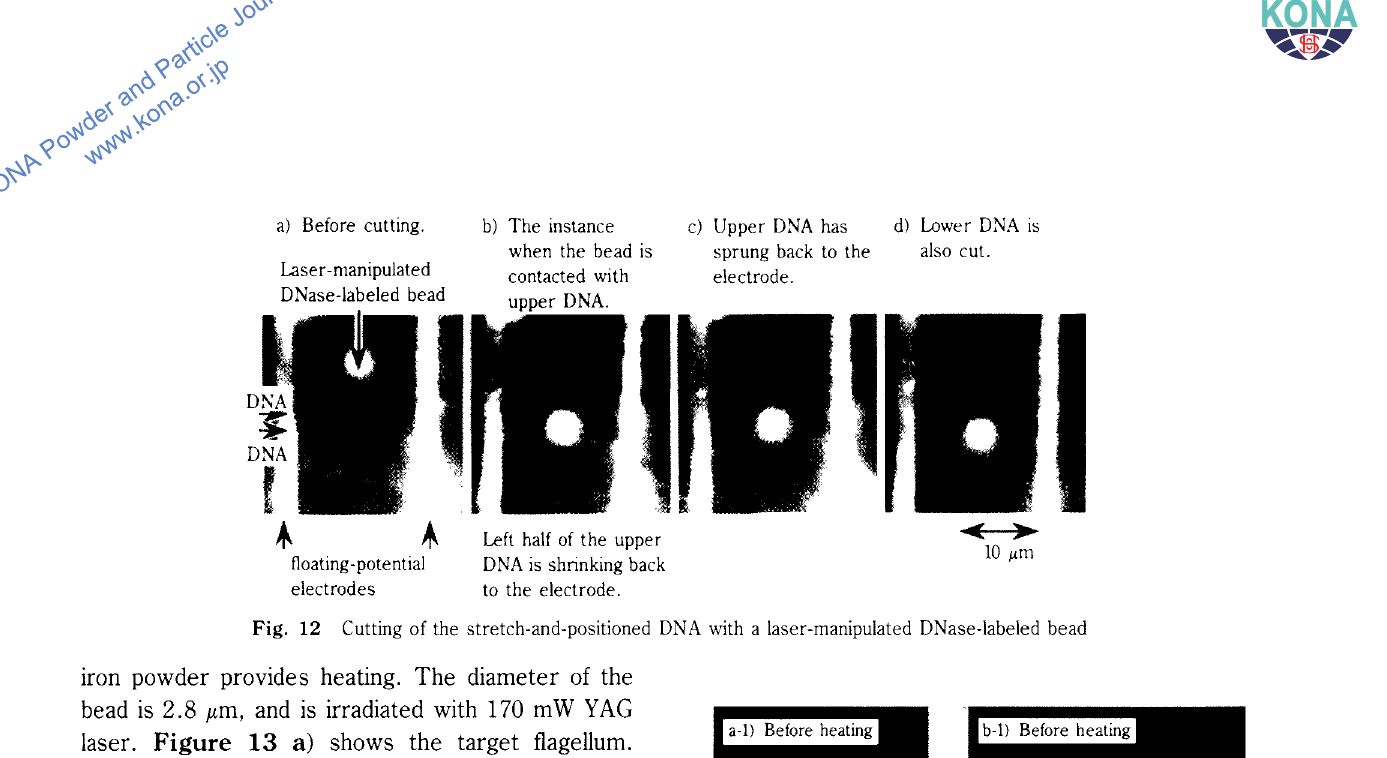
Fig. 13 Local conformation change and dissociation of a flagellum by laser-induced pin-point temperature